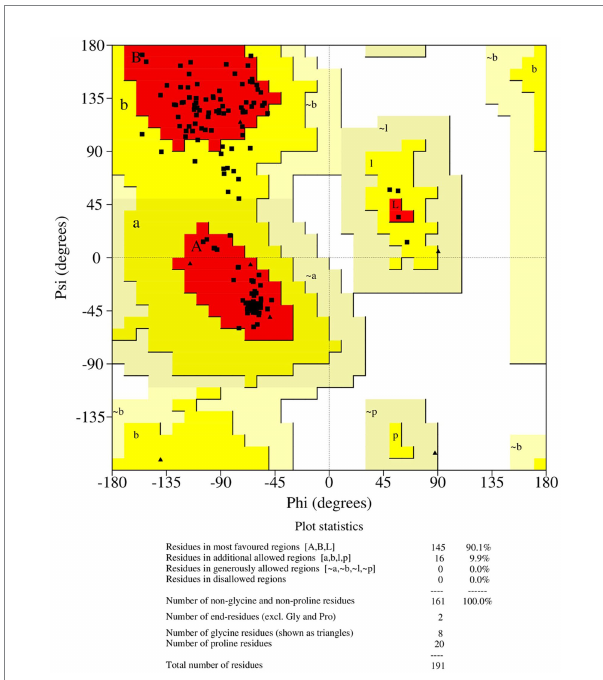
FIGURE 3 Ramachandran plot of the loop refined protein structure of ASP_